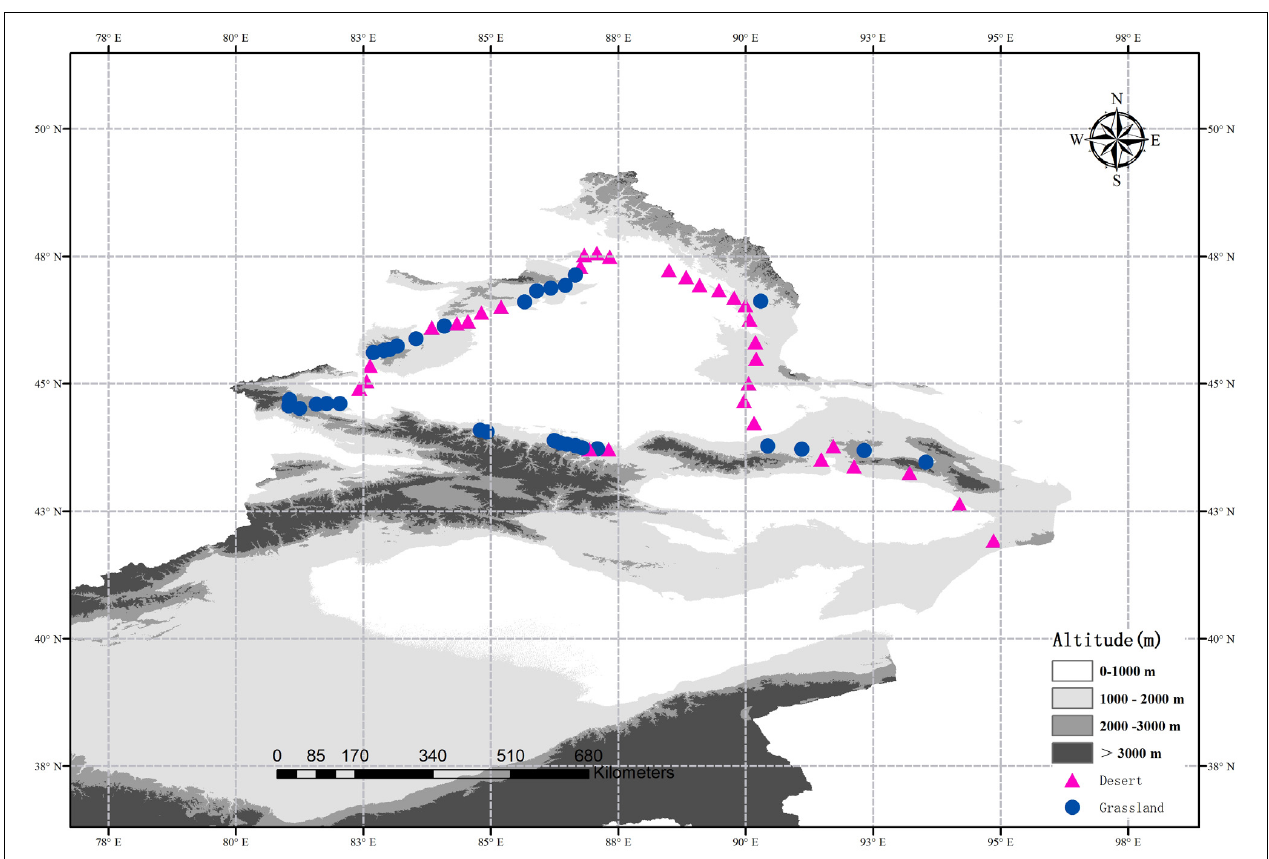
FIGURE 1 | Location of the desert (red triangles) and grasslands (blue dots) sampling sites across a typical dryland region in Northwest China. The altitude data is provided by Data Center for Resources and Environmental Sciences, Chinese Academy of Sciences (RESDC) (http://www.resdc.cn) and then we created the maps using ArcGIS 10